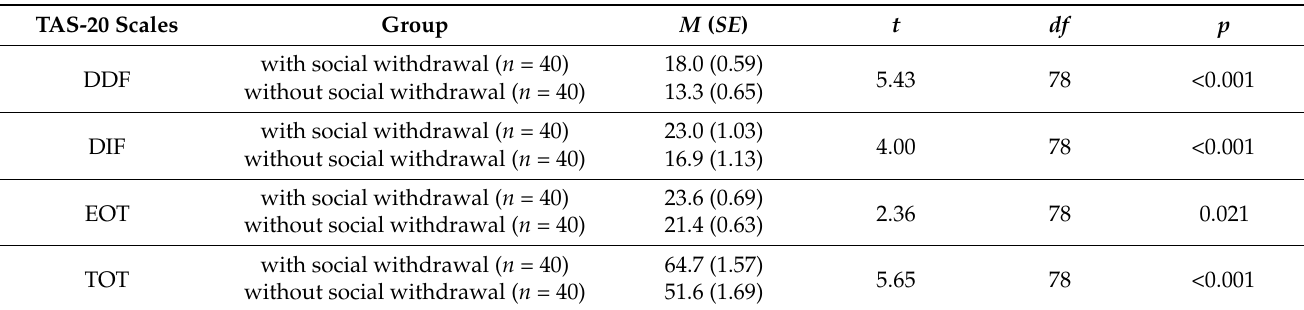
Table 2. Means and results of the t -tests, with scores in the Toronto Alexithymia Scale (TAS-20) as the dependent variables and group (with vs without social withdrawal) as the independent variable. TAS-20 Scales